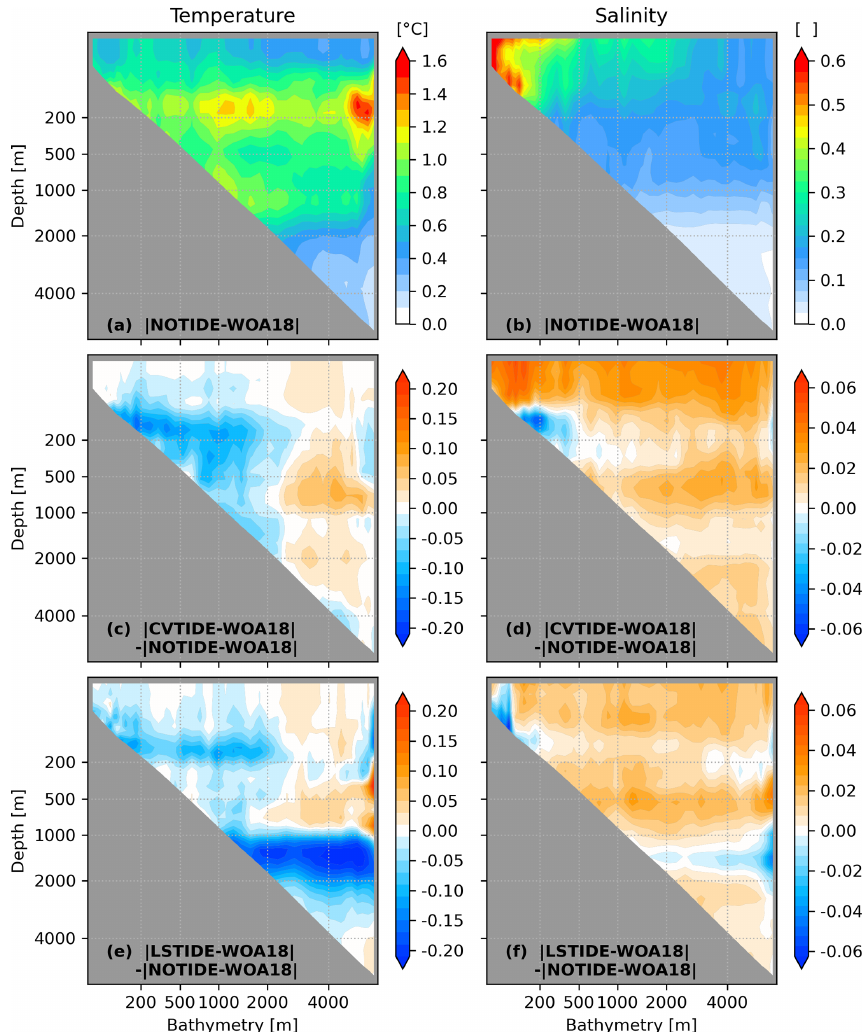
Figure 4. Bathymetry-averaged hydrographic biases between the model results and WOA18 with respect to water depths. The hydrographic biases are absolute values, and model mesh grids with the same bathymetry (maximum water depth) are assembled and averaged. Panels (c) – (f) are presented to show the differences with panels (a) and (b) ; thus the blue/red colours indicate that tidal effects decrease/increase model biases in the control run. The averaging is nodal-area-weighted, and the axes are scaled with a cube